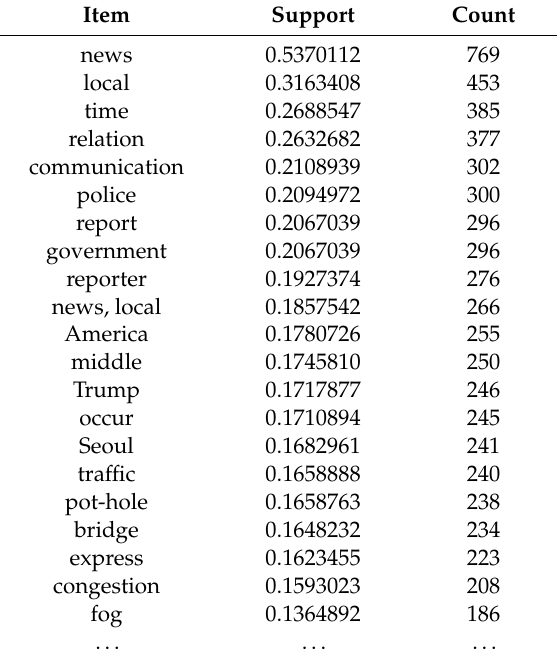
Table 4. Frequent Item Header